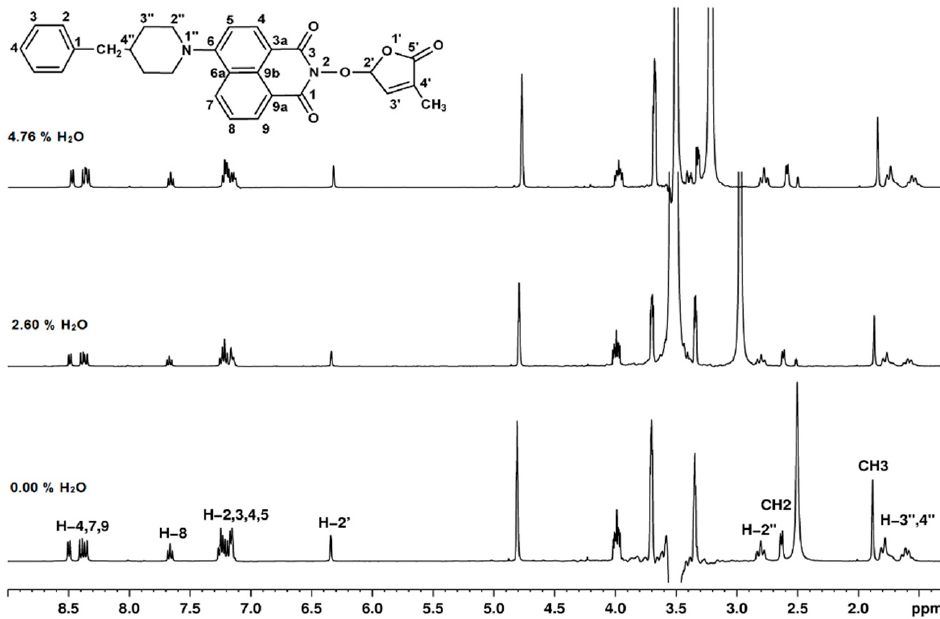
Figure 11. 1 H-NMR spectra recorded with dioxane suppression for compound 8 before and after the addition of 2.60% and 4.76% water content.